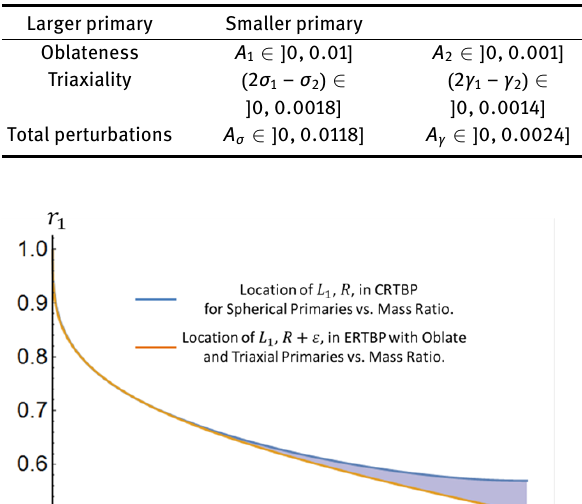
Table 1. Small parameters of different included perturbations